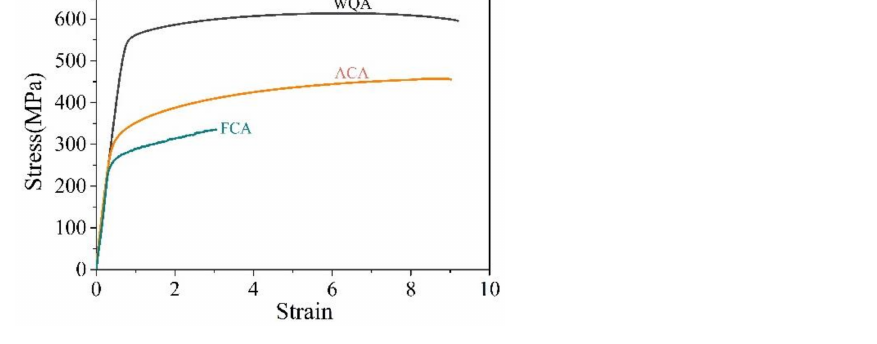
Figure 7. Tensile properties of 2A97 Al alloy that solution treated at 520 ◦ C for 1 h, cooled by various rates and aged at 155 ◦ C for 55 h.